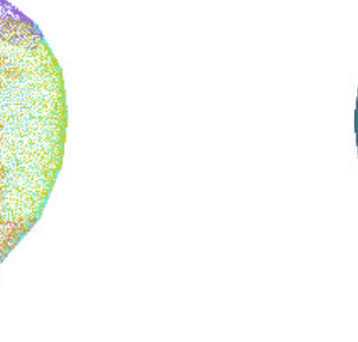
Figure 18. The final 3D reconstruction results: ( a ) Full registered point cloud; ( b ) Surface reconscheme 19. Cloud maps of contour deviation of hulls a–i calculated by MPCR-Net.